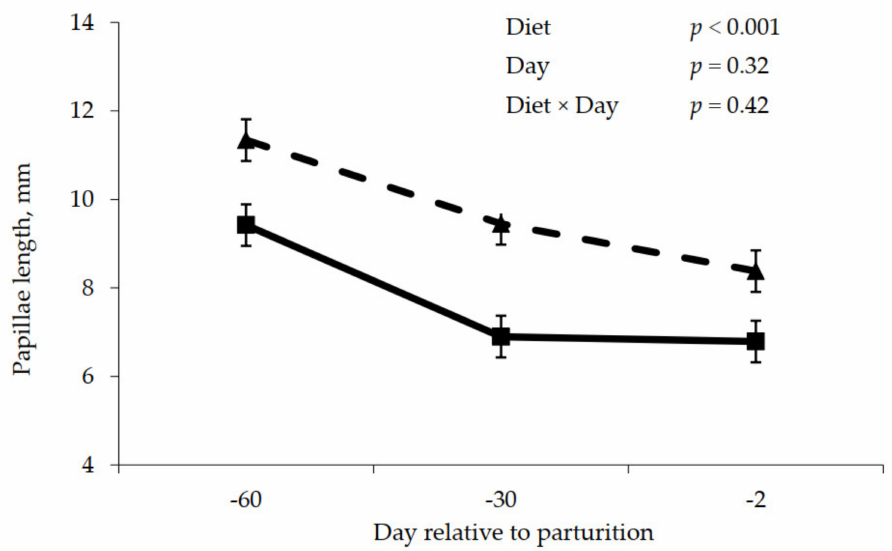
Figure 2. Prepartum papillae length for cows fed control (triangles) or molasses-containing (squares) diets during a 60 day dry period (error bars = pooled standard error of the mean, Experiment 2, n = 3).